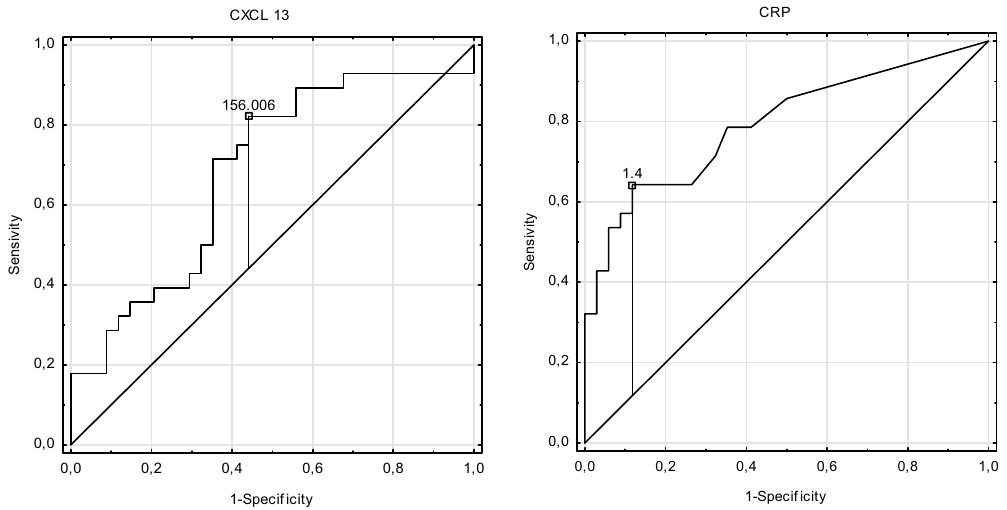
Figure 2. Receiver operating characteristic curve for CXCL-13 and CRP showing the ability of markers in distinguishing active vasculitis (Active Group) from long term remission (Long R Group) with cut-off points.